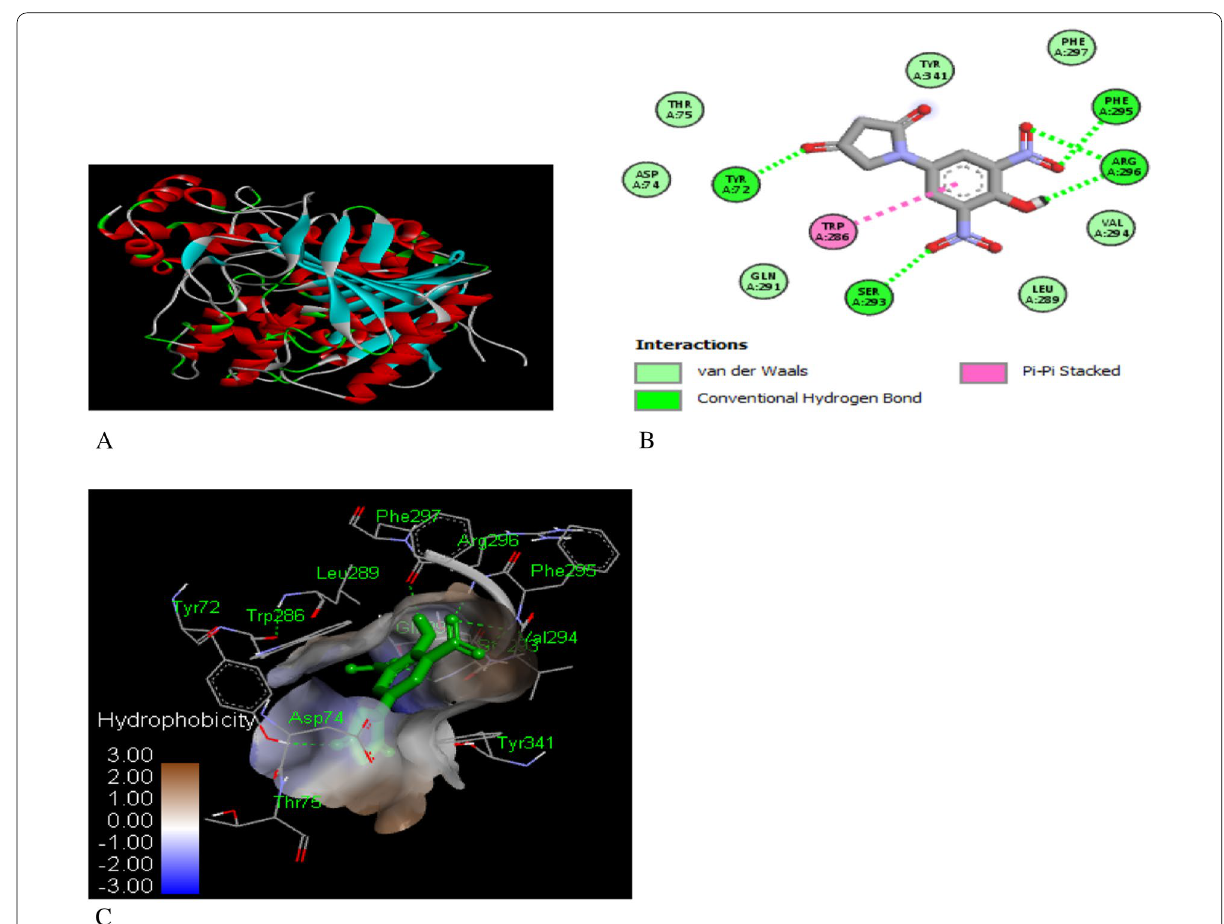
Fig. 5 A Structure of human ACE (PDB ID: 4EY7), visualized through PyRx, B 2D interactions, C hydrogen bond